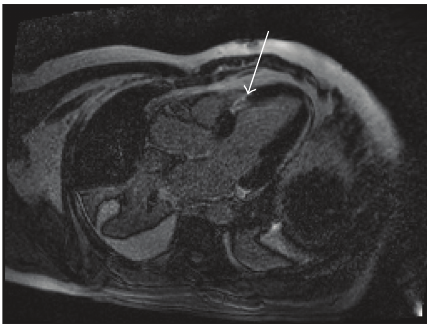
Figure 4: CMR (long axis) shows delayed enhancement in the interventricular septum